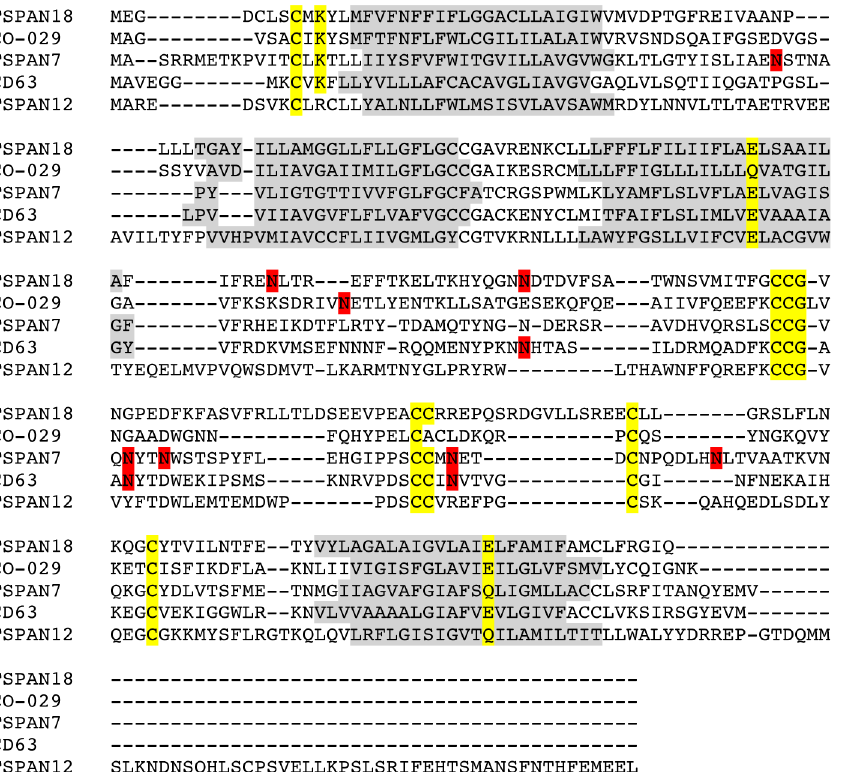
Fig 6. Sequence alignment of selected tetraspanins. Predicted localization of transmembrane helices with TOPCONS server [78] are indicated with a gray background. Residues conserved across the family – indicated in yellow and predicted glycosylation sites [79] are indicated with a red background. Sequence alignments were generated with the ClustalW server [80] by feeding 219 tetraspanin sequences from diverge spices to improve alignment